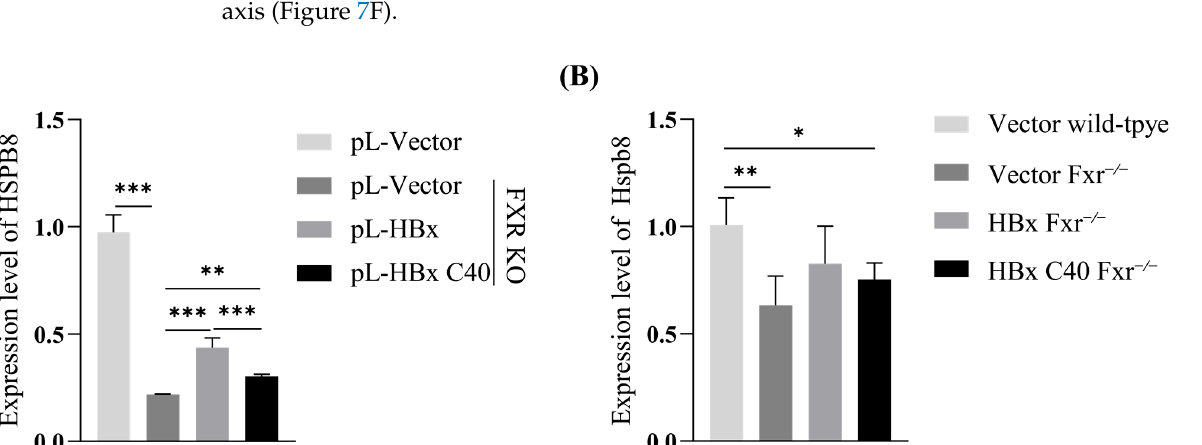
Figure 7. HBx/HBx C40-HSPB8-HK2-glucose metabolism axis in FXR-deficient HCC. ( A , B ) Differentially HSPB8 expression in cells and transient mouse models. ( C ) The overexpression of HSPB8 protein was detected by western blotting. ( D ) The mRNA expression of HK2 in HSPB8 + HBx C40 + FXR KO, and HBx C40 + FXR KO Hep3B cells were detected by qRT-PCR. ( E ) Fasting blood glucose, blood glucose 1 h after intraperitoneal injection of high glucose and 2-h postprandial blood glucose in transient mouse models. ( F ) Schematic diagram illustrating the induction of hepatocarcinogenesis, by HBx C40 expression combined with FXR deficiency, through inhibiting